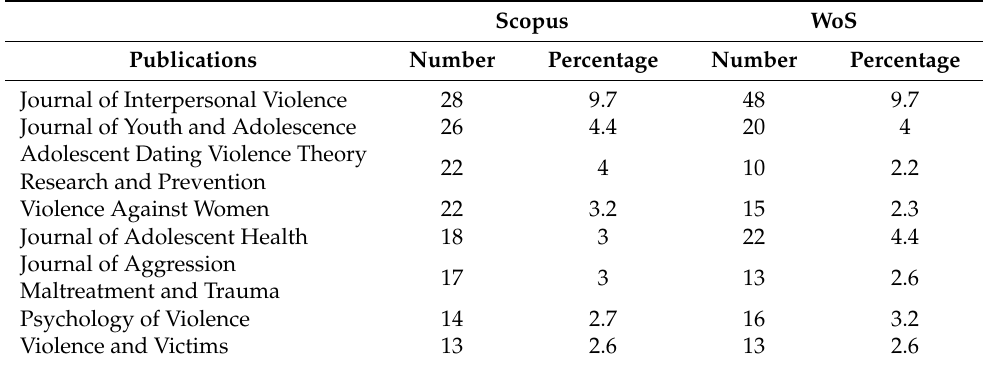
Table 8. Journals with the highest production in Scopus and